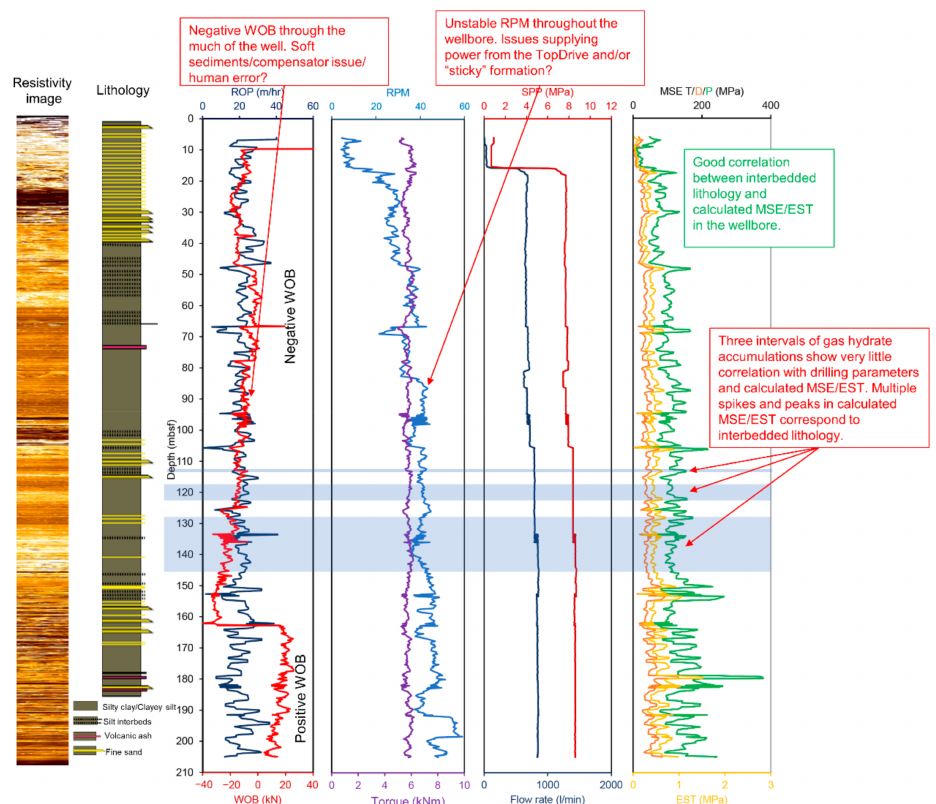
Figure 10. Depth-based series for wellbore U1517A correlated with lithology column and resistivity image. Shaded areas present the three gas hydrate intervals detected in the wellbore by MWD/LWD logging tools.